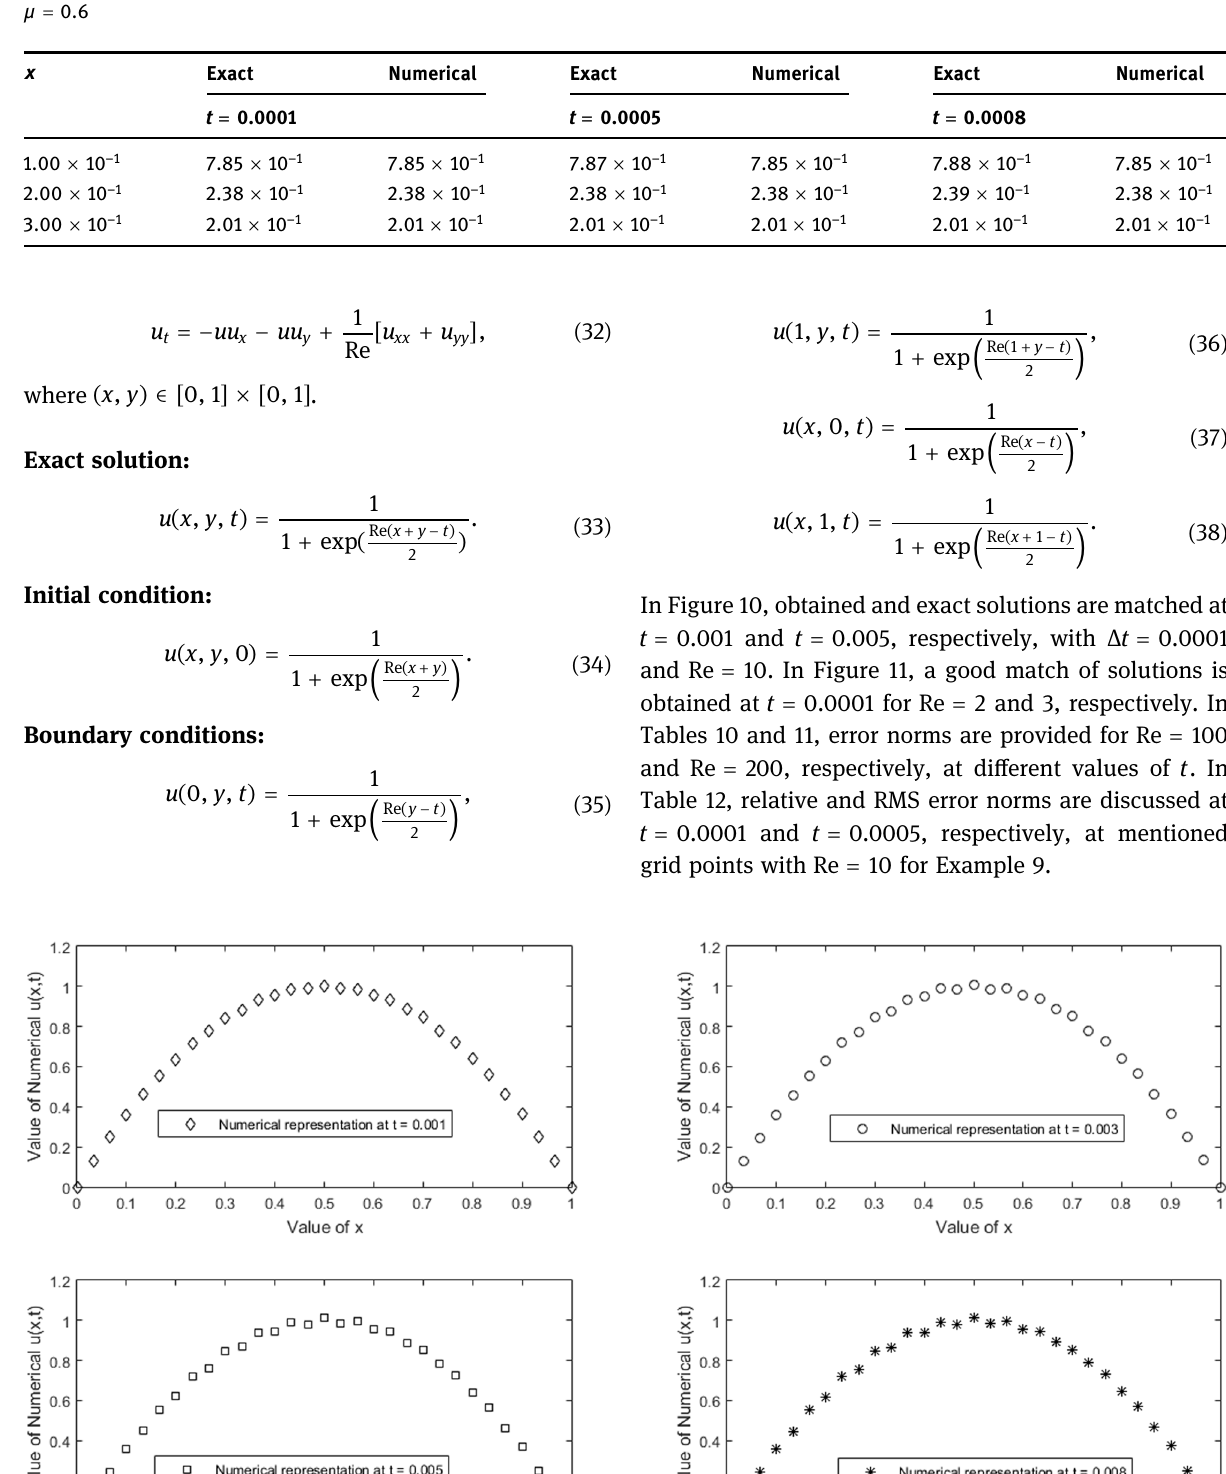
Table 9: Comparability of solutions at = t 0.0001 , = t 0.0005 , and = t 0.0008 , respectively, for